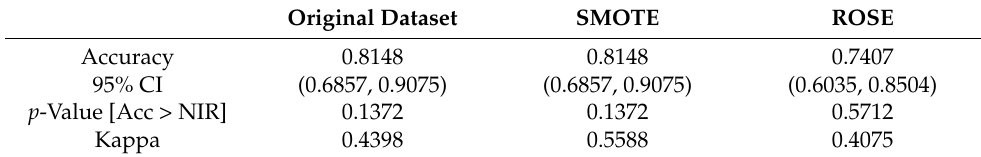
Table 3. Results of the Random Forest method on the Model B